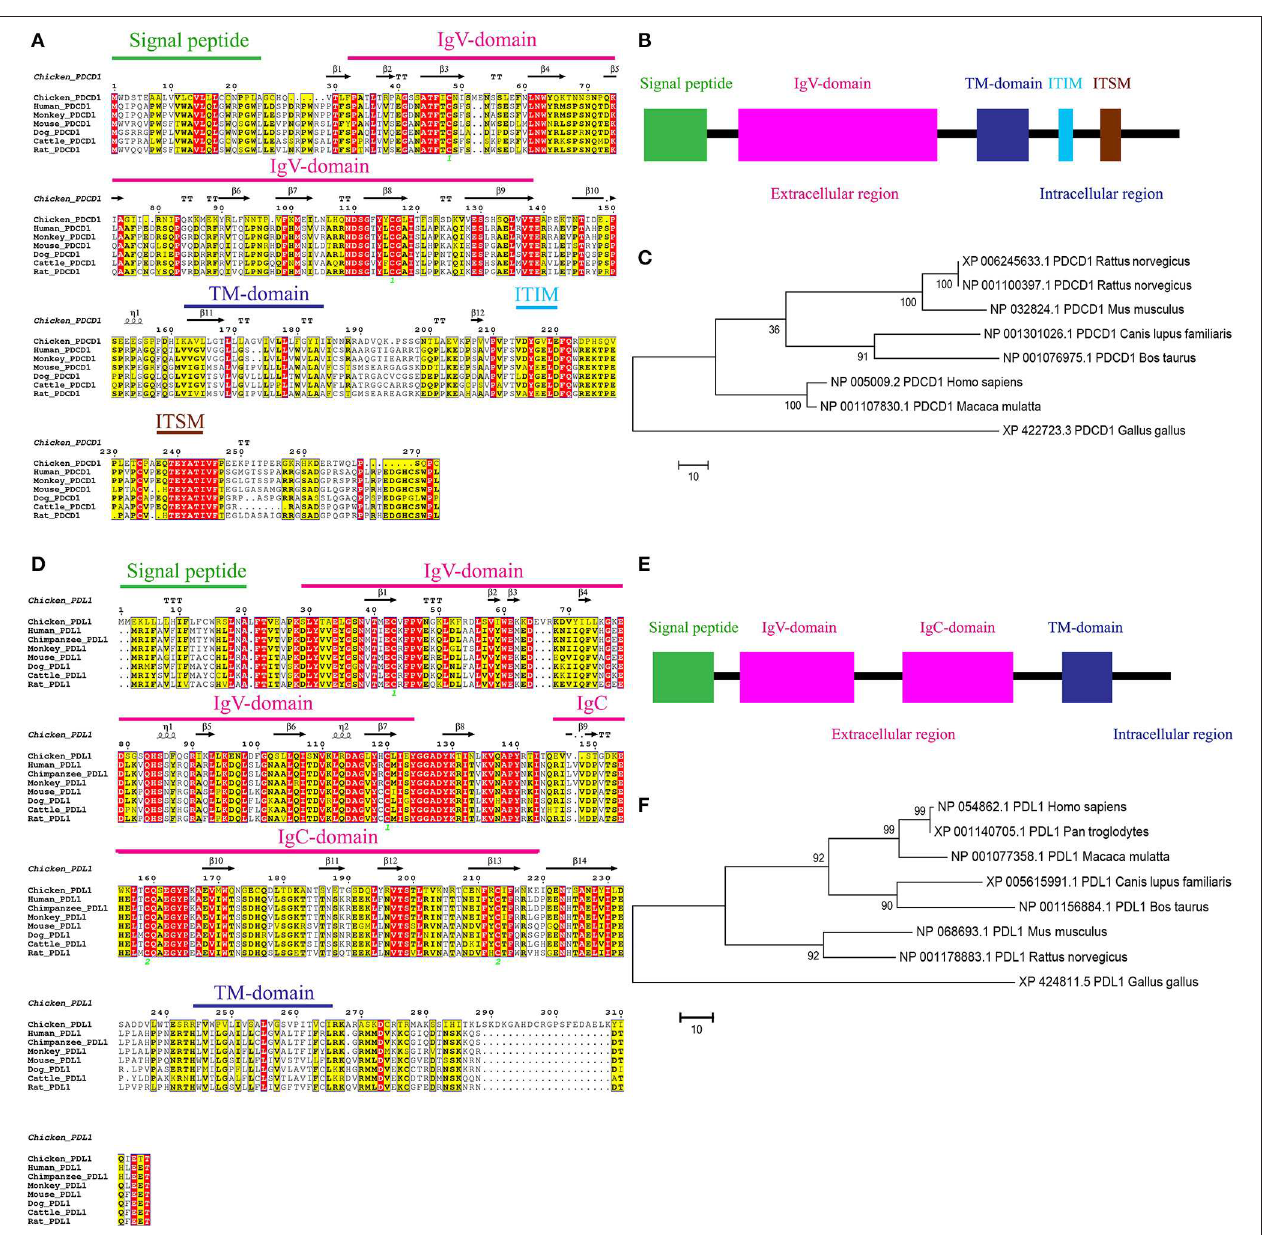
FIGURE 1 | Alignment of the amino acid sequences of chPD-1 and chPD-L1 with their mammalian orthologs. (A,D) Qualitative analysis of sequence identity and similarity using the ESPript 3.0 online tool. The predicted secondary structures are marked above the alignment (by helices with squiggles, β strands with arrows, and turns with TT letters) and are based on the PD-1 and PD-L1 structural models. Strictly conserved residues are boxed in white on a red background, more conserved residues are boxed in black on a yellow background, and less conserved residues are boxed in black on a white background. Shaded areas represent conservation of amino acid, the darker the shading, the more conserved the residue across species. The green number in Ig V domain of chPD-1 and Ig V and Ig C domains of chPD-L1 indicate that the two cysteine residues that form an intrachain disulfide bridge, respectively. (B,E) Predicted functional motifs in chPD-1 contains extracellular, transmembrane and intracellular domains and chPD-L1 contains extracellular, transmembrane and intracellular domains. (C,F) Maximum likelihood phylogenetic trees based on amino acid sequences of chPD-1 and chPD-L1 in relation to other animal species. Bootstrap values of 1,000 replicates was assigned for the analysis.